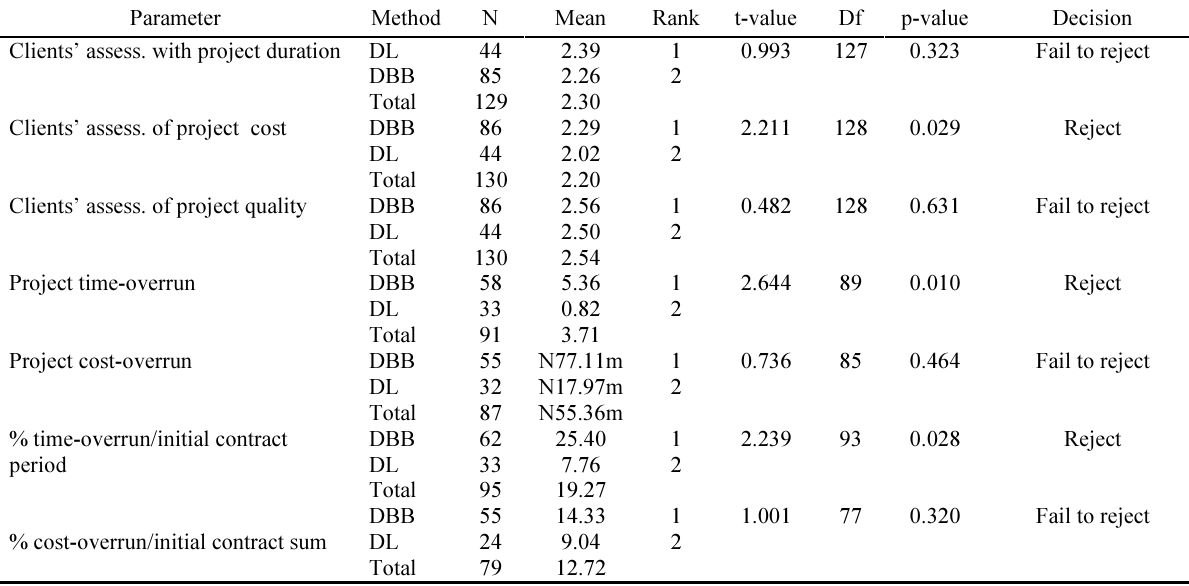
Table 8 . Results of t-test for differences in the outcome of projects procured by traditional contract and design-build methods